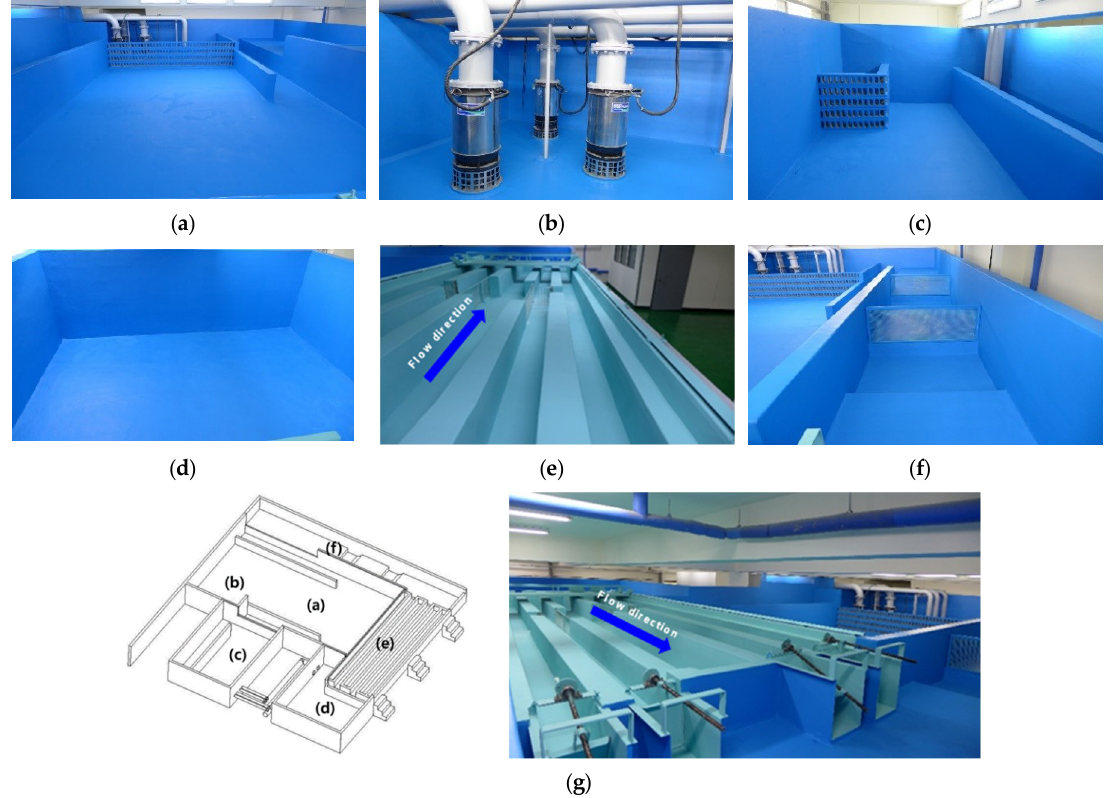
Figure 4. Hydraulic lab used to study agricultural drainage ditches: ( a ) water tank; ( b ) pump station; ( c ) head tank; ( d ) rectifying tank; ( e ) agricultural drainage ditches (400 mm); ( f ) return tank; ( g ) plan view.